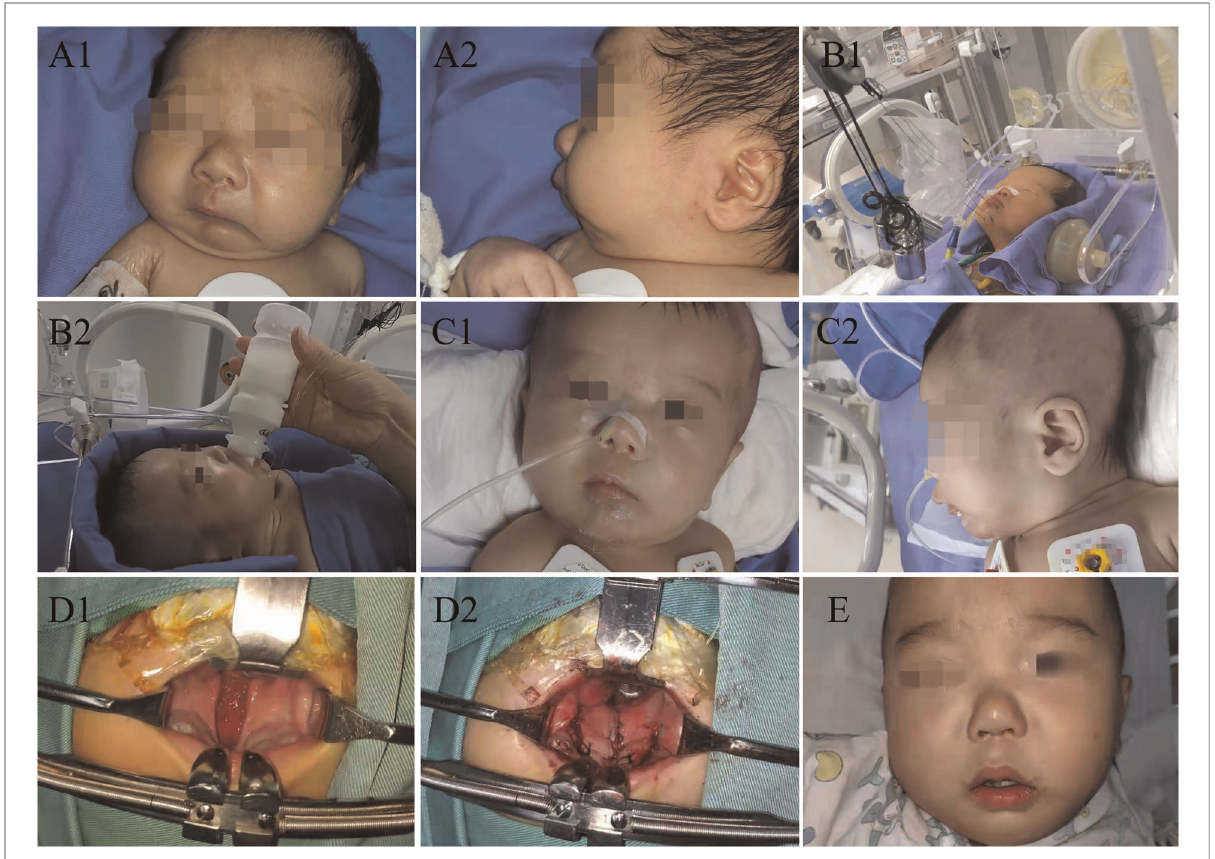
FIGURE 1 ( A1 ) Front view on admission; ( A2 ) side view on admission; ( B1 ) traction; ( B2 ) oral feeding in traction; ( C1 ) front view after removing the wire; ( C2 ) side view after removing the wire; ( D1 ) cleft palate repair; ( D2 ) cleft palate repair; ( E ) after cleft palate repair, visible the central incisors and lateral